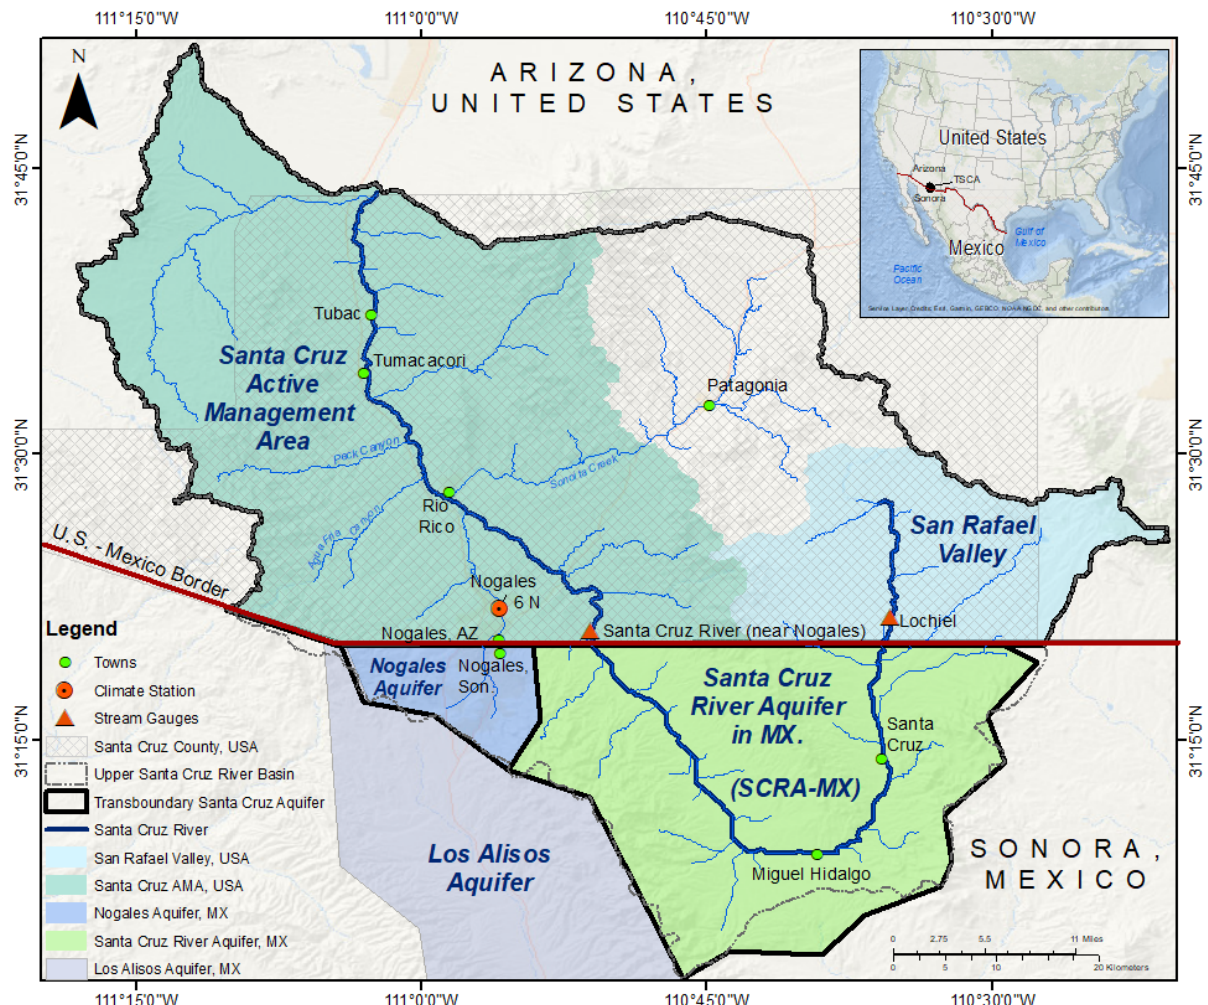
Figure 1. Political-administrative domains in the Transboundary Santa Cruz Aquifer. Because of the region’s scarce water resources, population increase, and growing groundwater demands on both sides of the border, the TSCA was selected for the